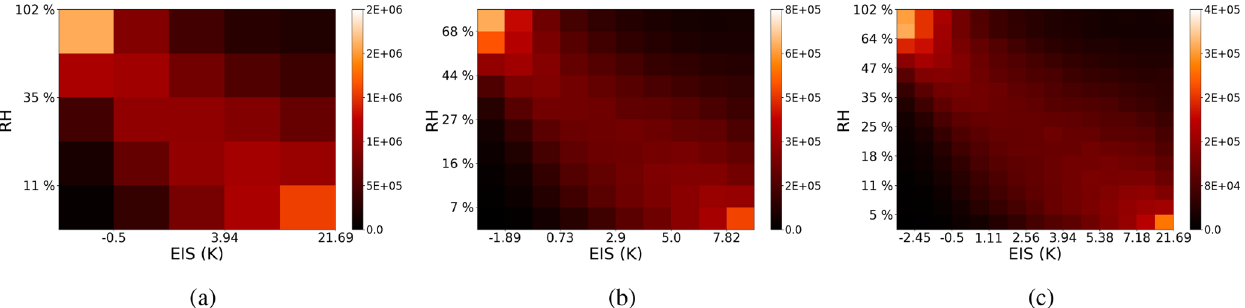
Figure 5. Frequency of clouds partitioned into (a) 25, (b) 100, and (c) 225 environmental regimes of EIS and RH 700